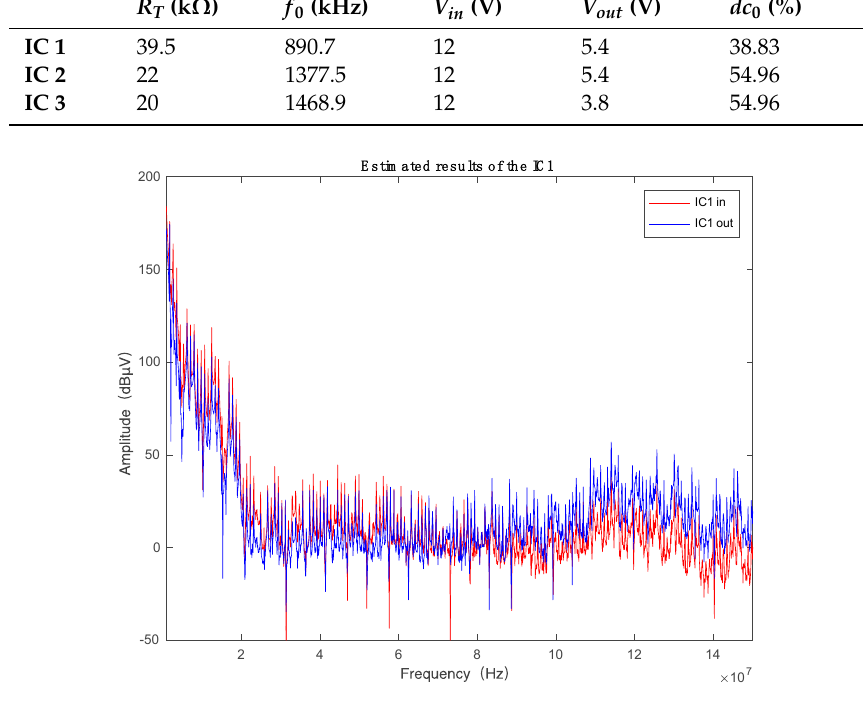
Table 3. Design parameters of the three chips.